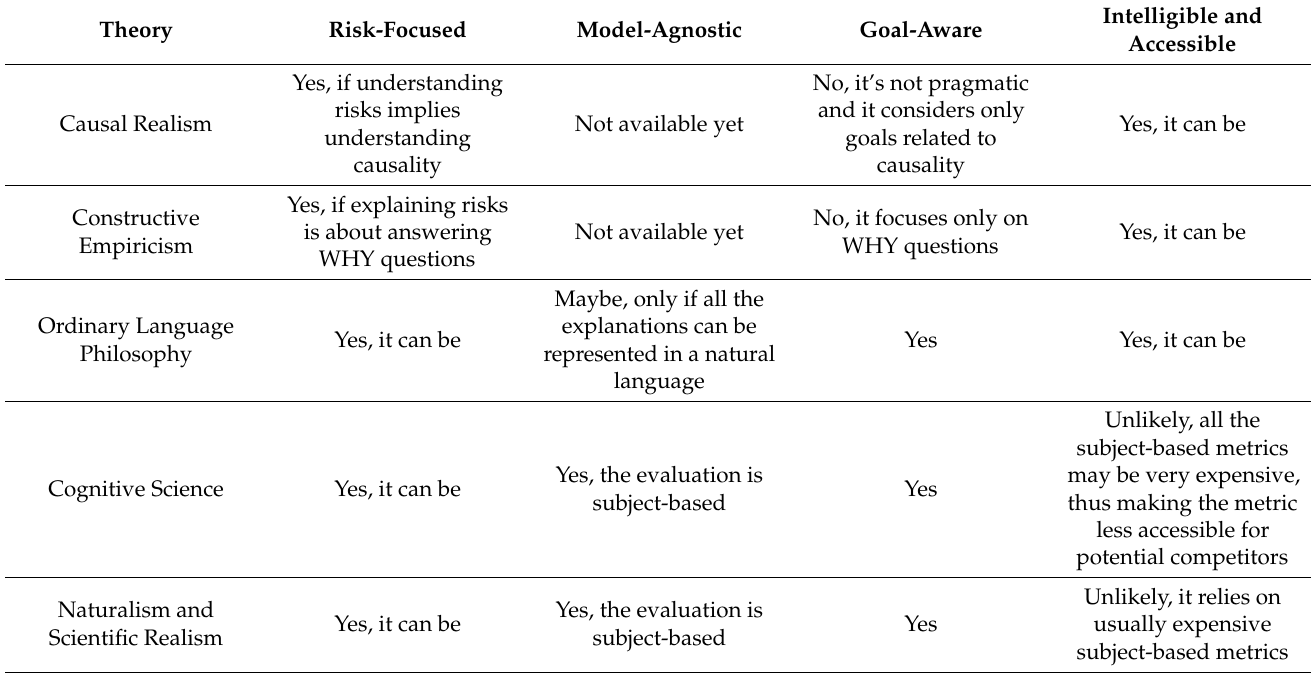
Table 3. This table shows how the different philosophical definitions of explainability are aligned to the properties we identified in Section